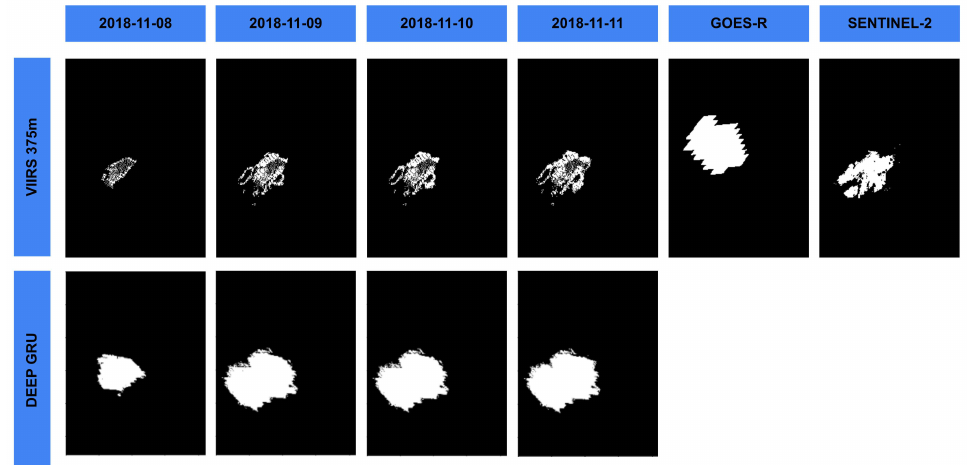
Figure 13. Burned area progression mapping of VIIRS 375 m active fire product and proposed method for 8 November 2018 to 11 November 2020 until Sentinel-2 image is available. Accumulated image from GOES-R active fire product from 8 November 2018 to 11 November 2020 is served as the